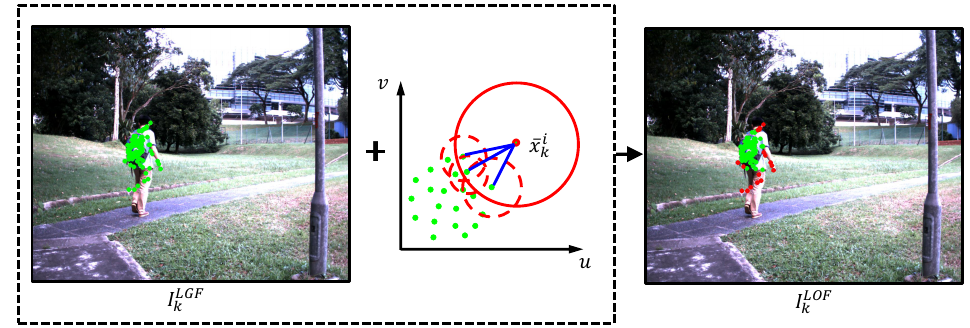
Figure 4. Illustration of local outlier factor (LOF) module. The green points on the I LGF are the FAST k features from the LGF module, i.e., F 2 . The LOF module is developed to further remove the outliers, as the red points shown on the I LOF . The green points on the I LOF are final reliable output FAST k k features in our visual tracking